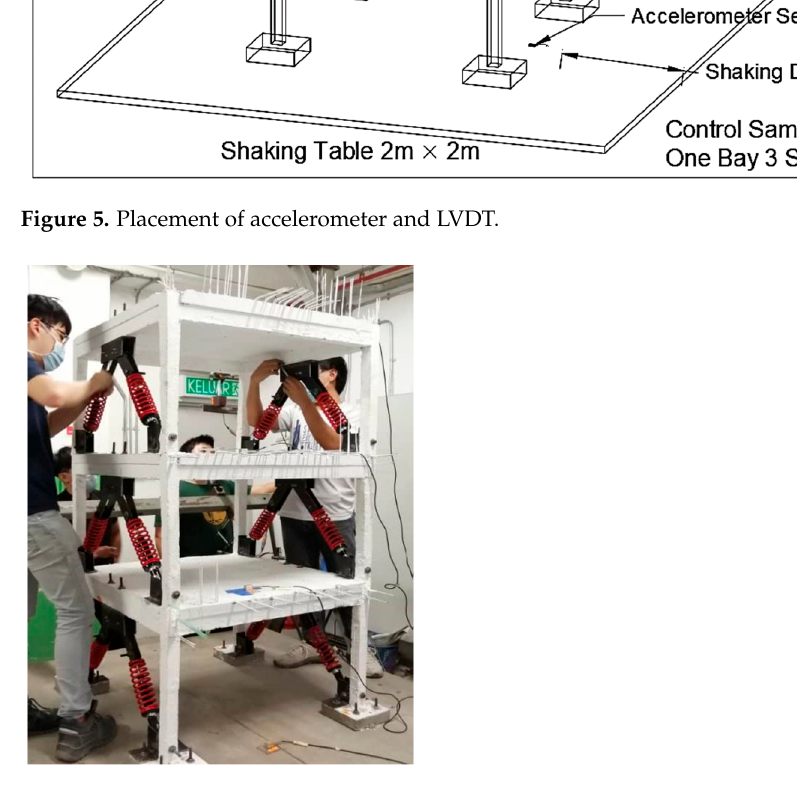
Figure 6. Arrangement of viscous dampers.